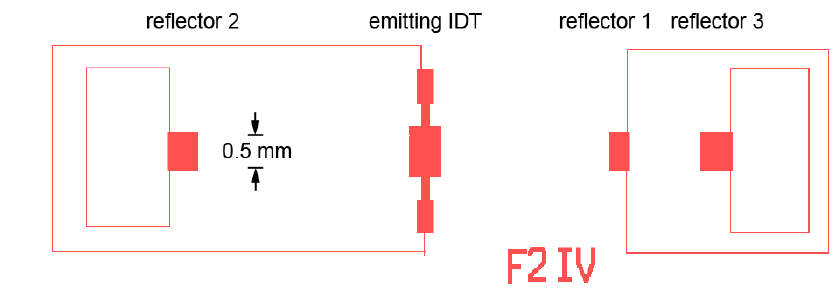
Figure 9. Mask layout for SAW sensor used in this work.